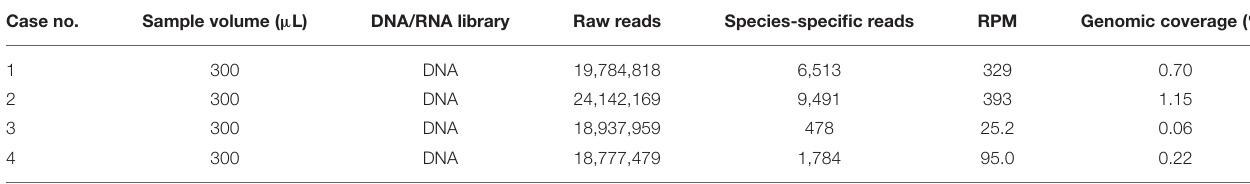
TABLE 3 | The NGS of CSF of the four patients with neurocysticercosis. Case no.